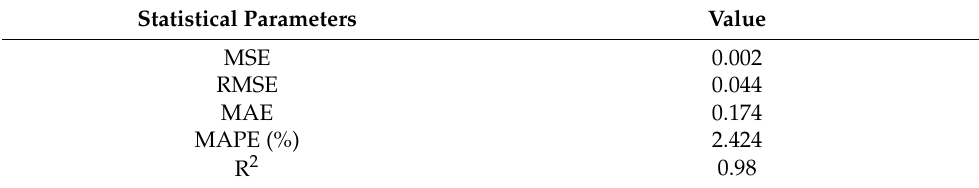
Table 4. Statistical parameters of the developed ANFIS model. Statistical